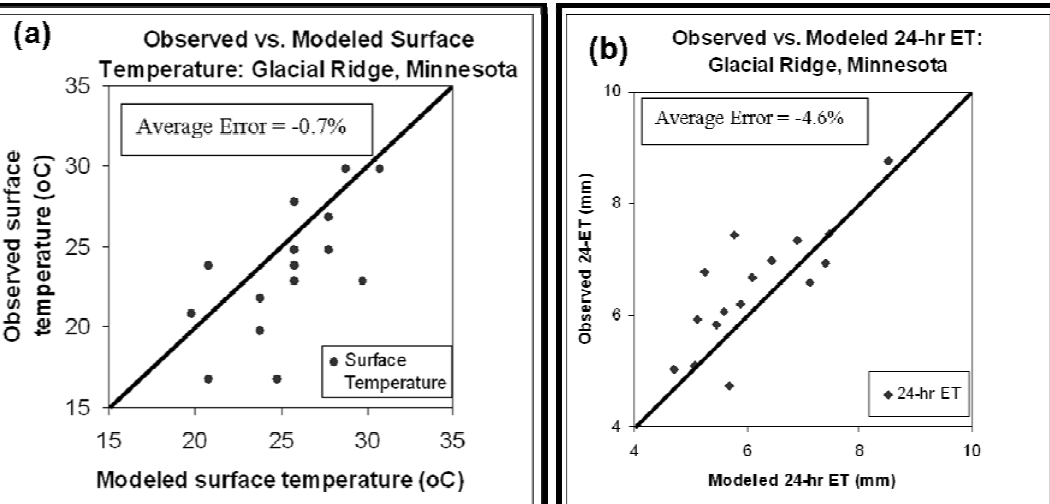
Figure 4. Observed vs . modeled (a) ET and (b) surface temperature from Glacial Ridge wetland, Minnesota using remote